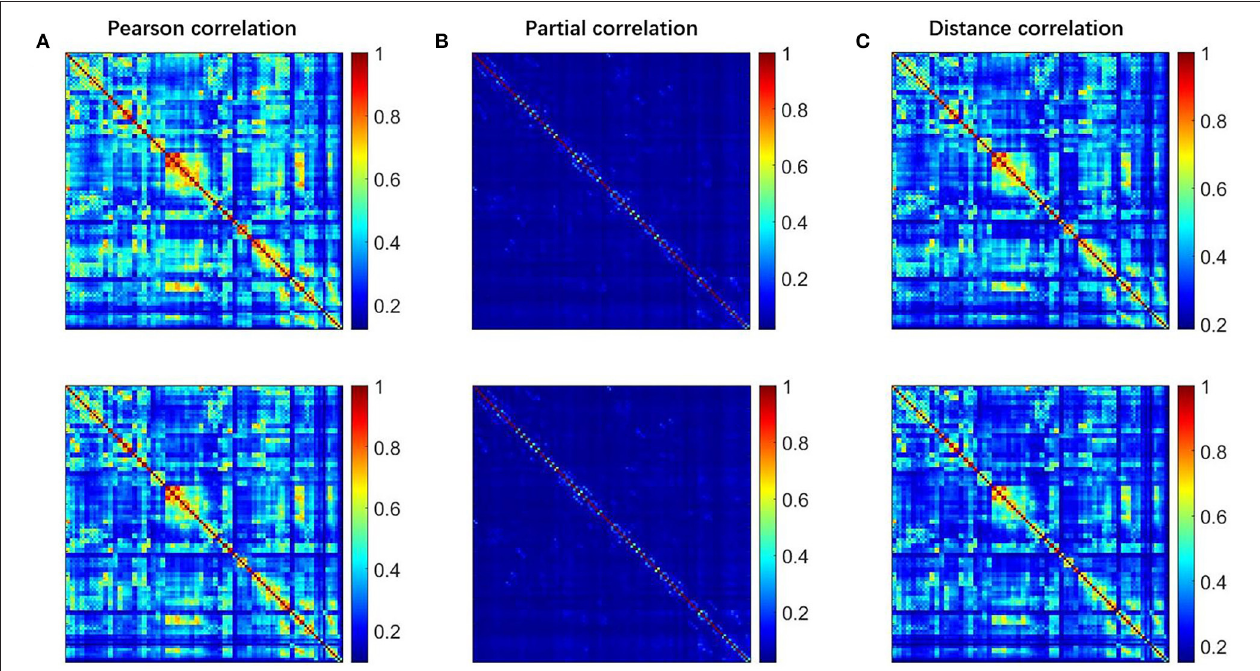
FIGURE 2 | The FC matrices for HCS and the patients with OCD. The first row is for HCS and the second row is for the patients with OCD. (A) Pearson correlation, (B) partial correlation, and (C) distance correlation. FC, functional connectivity; OCD, obsessive-compulsive disorder; HCS, healthy control subject.